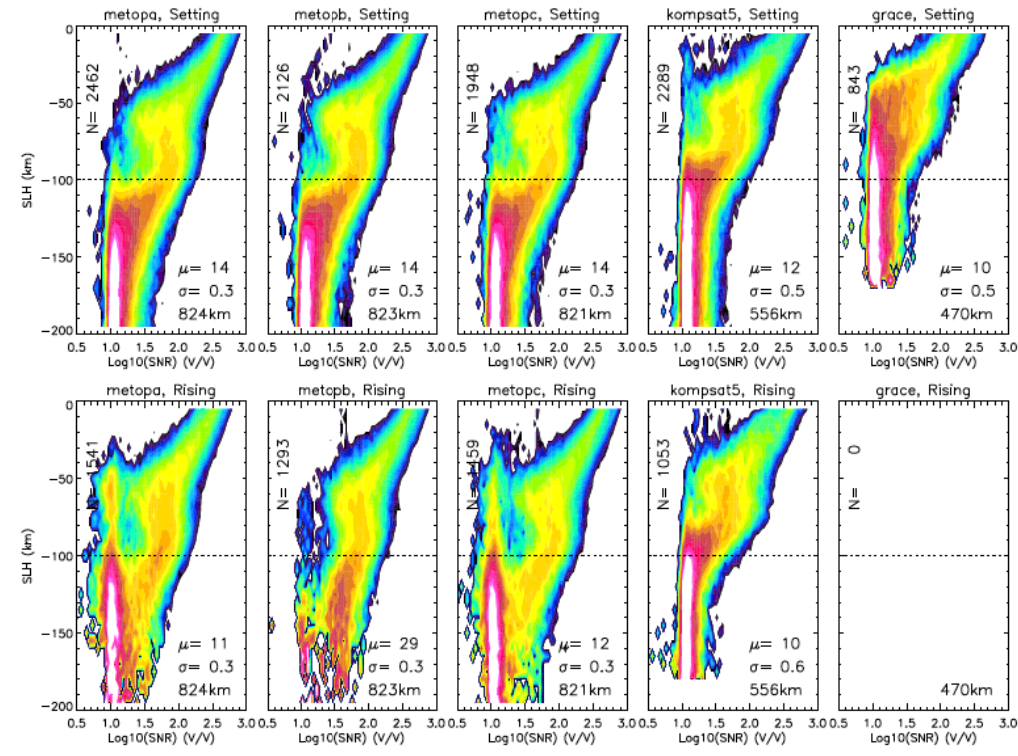
Figure A3. As in Figure A2 but for MetOp-A/B/C, Kompsat-5, and GRACE. The 2020 MetOp, 2018 Kompsat-5, and 2009 GRACE data are used in the analysis.